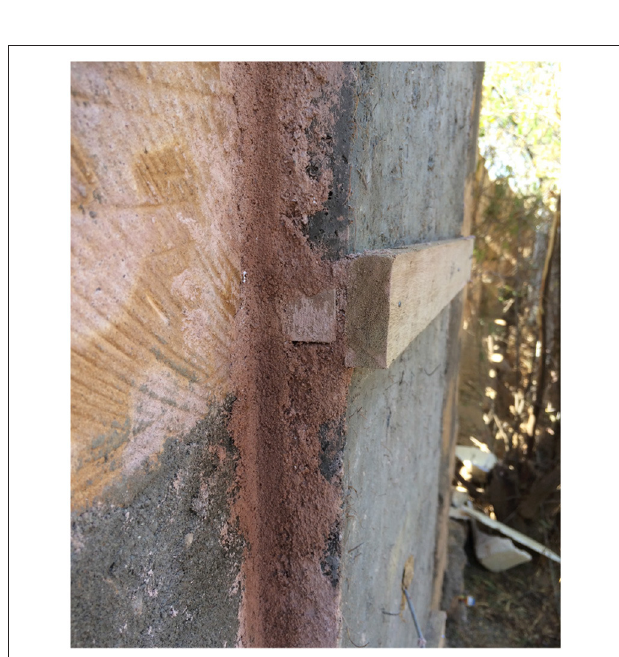
FIGURE 3 | Bhuj test wall using fiber cement panel on a mortar bed.